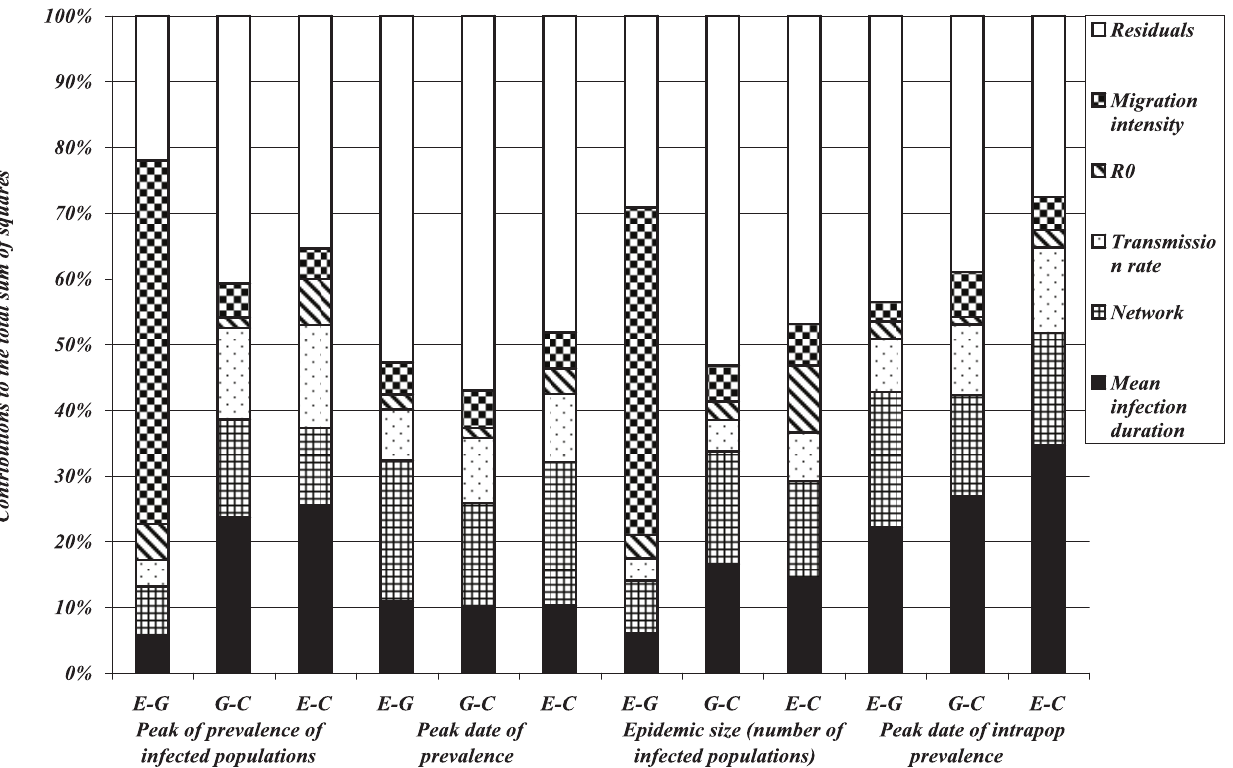
Figure 9. Results of ANOVA on 960 simulated scenarios of epidemic spread with parameter values given in Table 2. Dependent variables (on x-axis) are logarithm of means (over the non early extinct dynamics) of global variables (referring to populations): size and duration of the epidemic , size and date of the epidemic peak . For each of these outputs three variants are considered with respect to the distribution of infection duration: ’ E { G ’ (difference between the value of the output simulated with the exponentially distributed infectious period and the value corresponding to the gamma distributed infectious period), ’ G { C ’ (difference between the value of the output simulated with the gamma distributed infectious period and the value corresponding to a constant infectious period) and ’ E { C ’ (difference between the value of the output simulated with the exponentially distributed infectious period and the value corresponding to a constant infectious period). Different pattern fills correspond to contributions of five input factors ( mean infection duration , network , transmission rate , R 0 and migration intensity ) to the variation in outputs amongst scenarios.